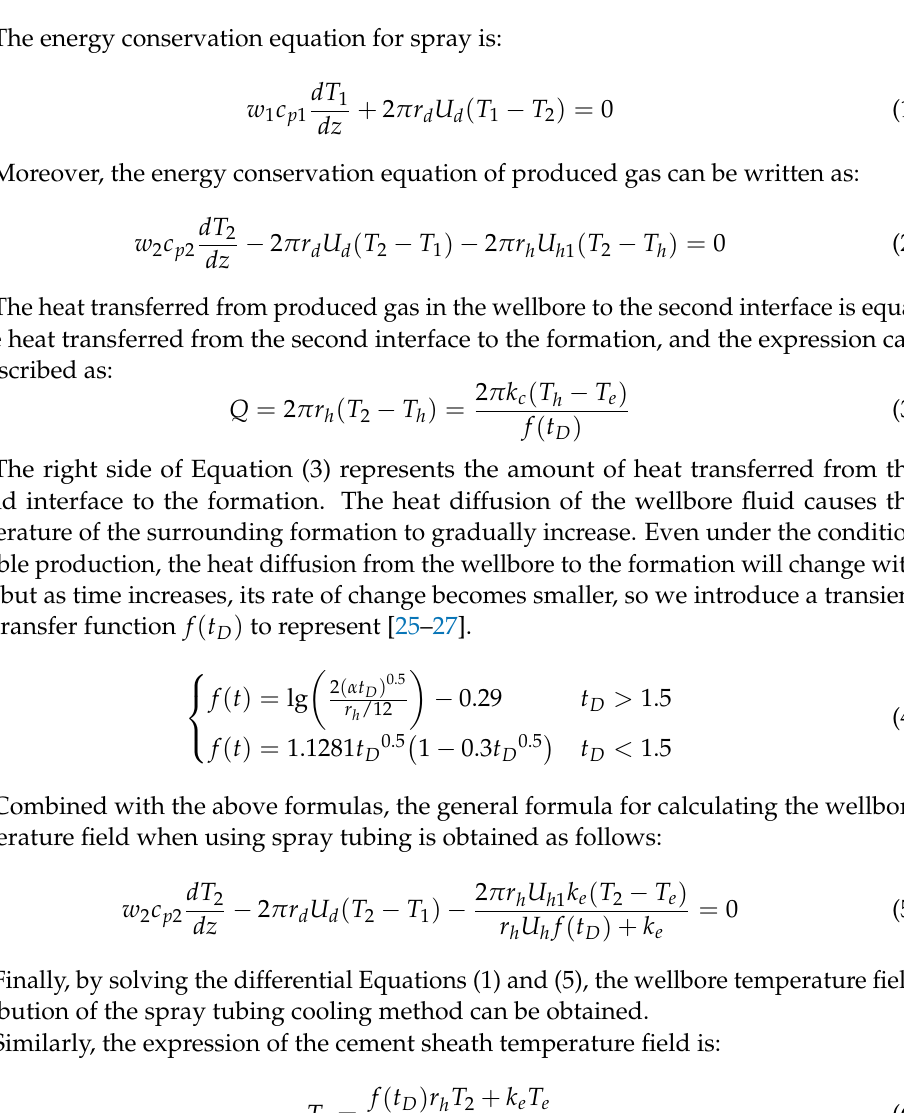
Figure 2. Calculation model of temperature field using spray tubing water injection